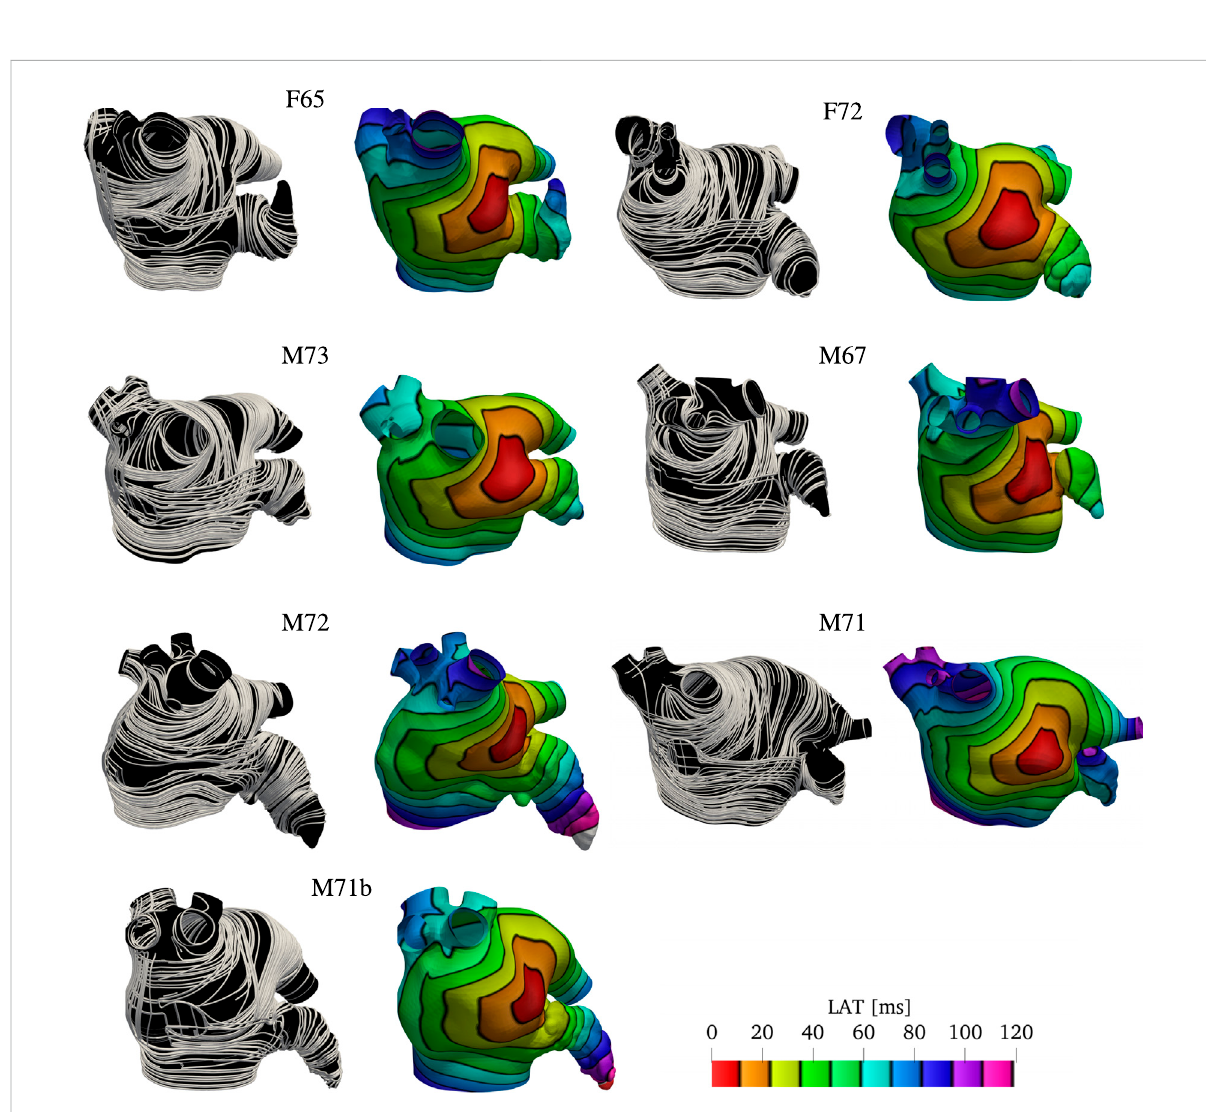
FIGURE 7 Fibers and local activation times for all geometries other than M75 and M52. Notice we show the fi nal fi ber architecture, with endocardial and epicardial layers superposed, in this visualization. Although the size of the geometries look similar, the sizes of the LA are different. That is evident by denser isolines and longer activation times in the LAA and PVS for larger geometries, such as